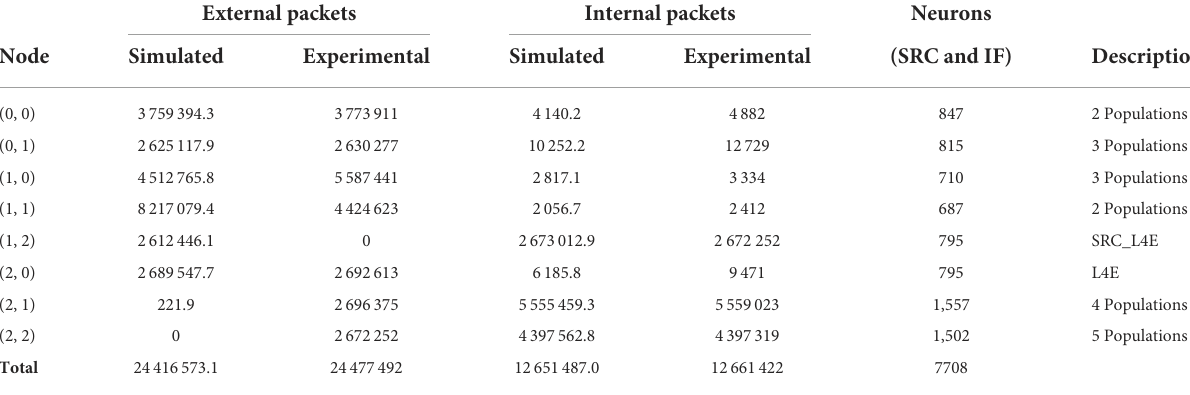
TABLE 3 Simulated communication traffic results for the test case mapped with the PACMAN procedure.